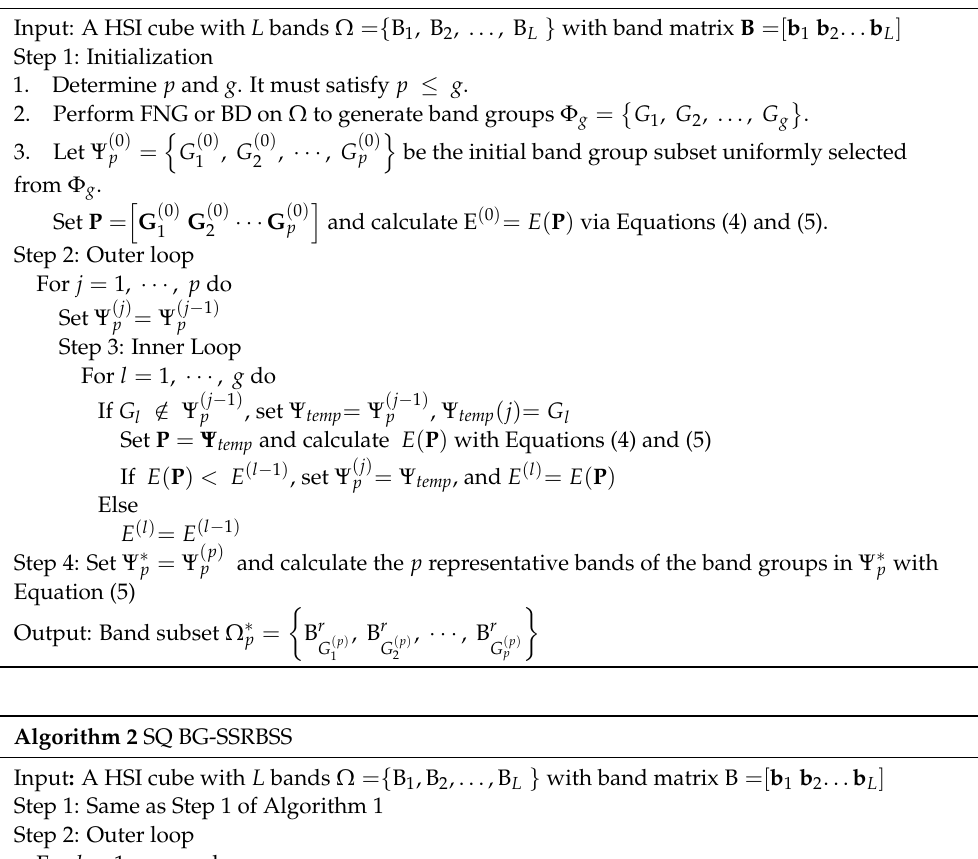
Algorithm 1 SC BG-SSRBSS